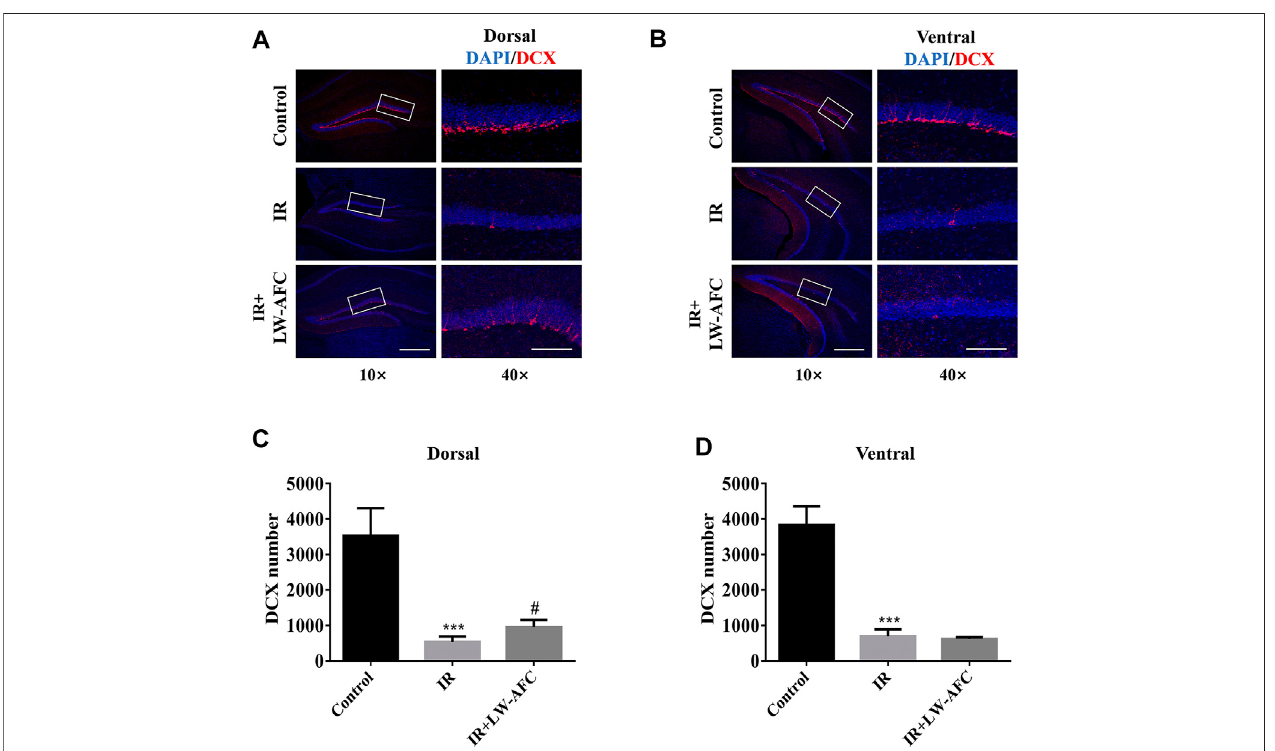
FIGURE 5 | LW-AFC increases the number of immature neurons preferentially in the dorsal hippocampus of IR mice on day 1 after irradiation. Representative immuno fl uorescenceimagesofDCX-positivecellsinthe (A) dorsalhippocampusand (B) ventralhippocampus.Theareaofwhitesquareframeintheleftimageindicates the enlarged image of DCX-positive cells in the right. The confocal images in the left are of 10 × , and the enlarged images in the right are of 40 × . Quanti fi cation of DCX-positive cells in the (C) dorsal hippocampus and the (D) ventral hippocampus. The scale bar in the left image (cid:2) 300 μ m, and the scale bar of the enlarged image (cid:2) 100 μ m. The values denote mean ± S.D., n (cid:2) 4. *** p < 0.001, versus the control group; # p < 0.05, versus the IR group. Abbreviation: IR,